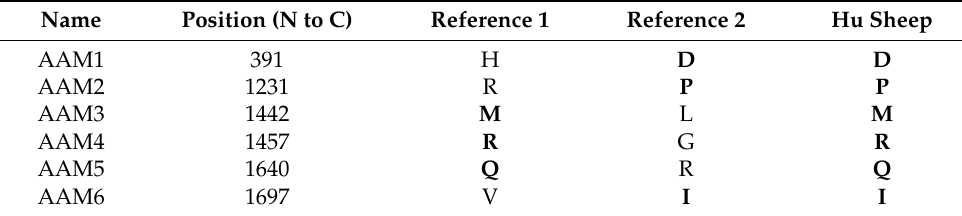
Table 5. Amino acid mutation (AAM) of PAPPA2 in Hu